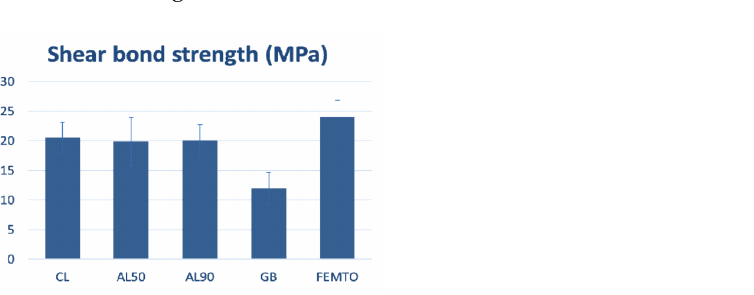
Figure 1. Mean values and standard deviation (bars) of shear bond strength values.